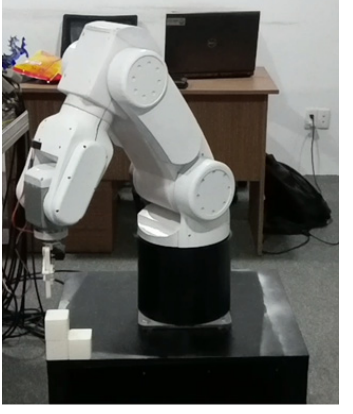
Figure 7. Six DOF robot arm